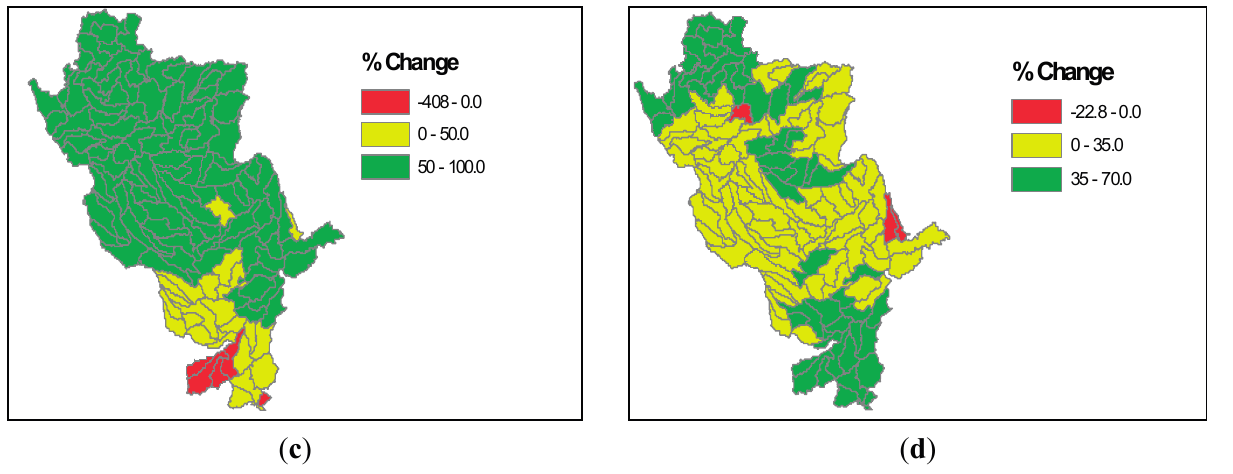
Figure 11. Spatial variation in the % change over baseline of ( a ) Water Yield; ( b ) ET; ( c ) Sediment load; and ( d ) Total Nitrogen load from a 10% decrease in precipitation and 2 °C increase in